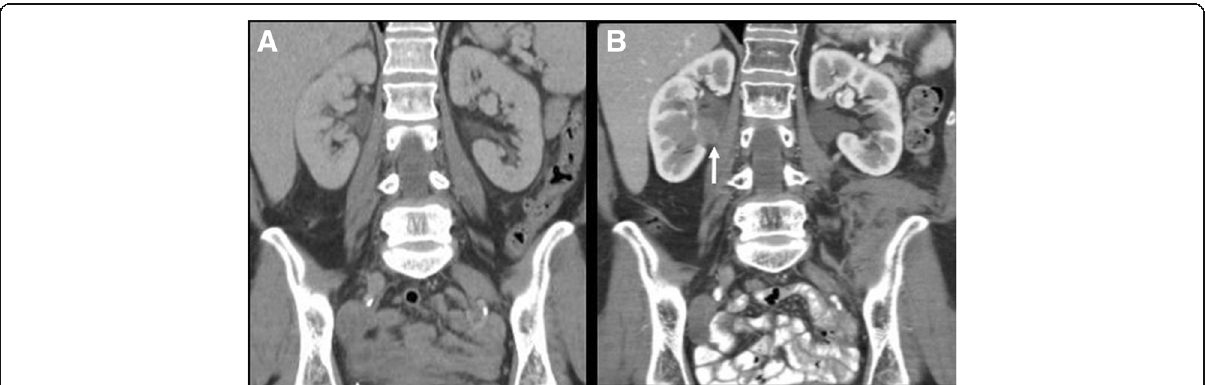
Fig. 6 A 59-year-old woman with follicular lymphoma presenting with acute abdominal pain. a Coronal reconstructed CT image acquired during portal venous phase 6 months before the onset of new symptom shows unremarkable appearance of the abdomen. b Axial CT image acquired during late arterial phase at the time of symptom onset shows a mass within the right renal pelvis (arrow). Biopsy of the lesion shows histologic transformation to diffuse large B cell lymphoma